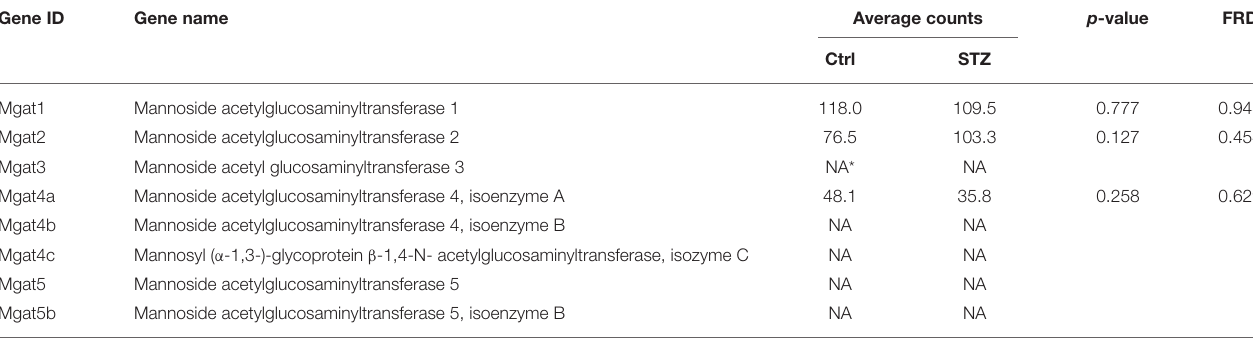
TABLE 2 | Summary of acetylglucosaminyltransferase genes from kidney IM by RNA-seq